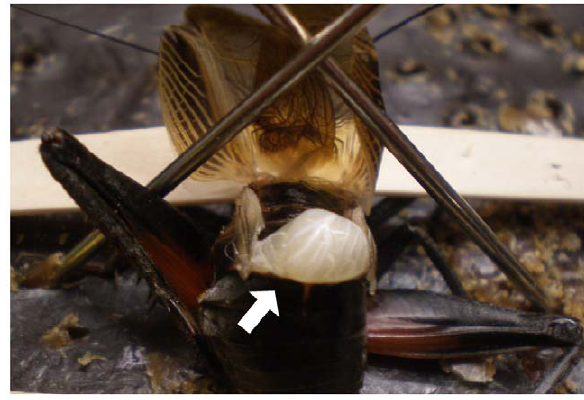
Figure 2. Gryllusfirmus male undergoing a surgical castration. The incision is made between the dorsal 2 nd and 3 rd segments, and each testis (arrow) is gently removed.